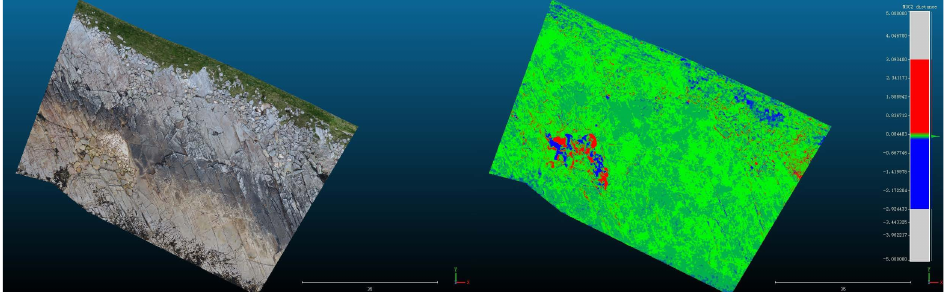
Figure 10. Visualization of M3C2 results in CloudCompare, where red (positive value) indicates the appearance of the boulder, blue (negative value) indicates the disappearance of the boulder, and green (value close to 0) indicates no change. To highlight boulder movements, the colour bar was adjusted to display the core points with M3C2 values between − 0.15 m and 0.15 m in green, and the core points below − 0.15 m and above 0.15 m in blue and red, respectively.